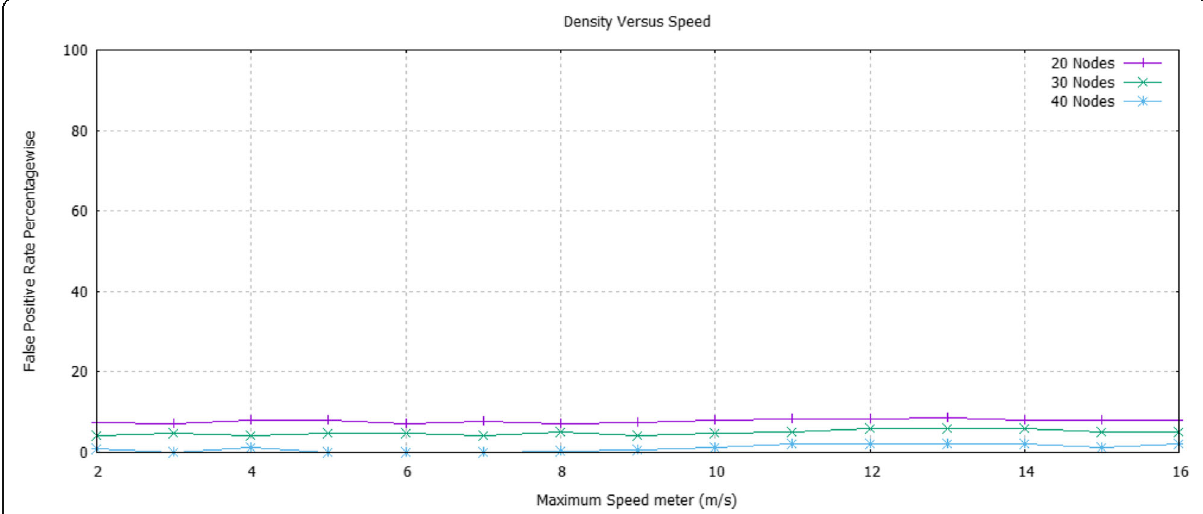
Fig. 11 Density versus speed false positive rate. Shows the simulation results of the density versus speed experiment. The x -axis represents the maximum speed per metre second, while the y -axis represents the FPR. The experiment was conducted in three different instances of 20, 30 and 40 mobile